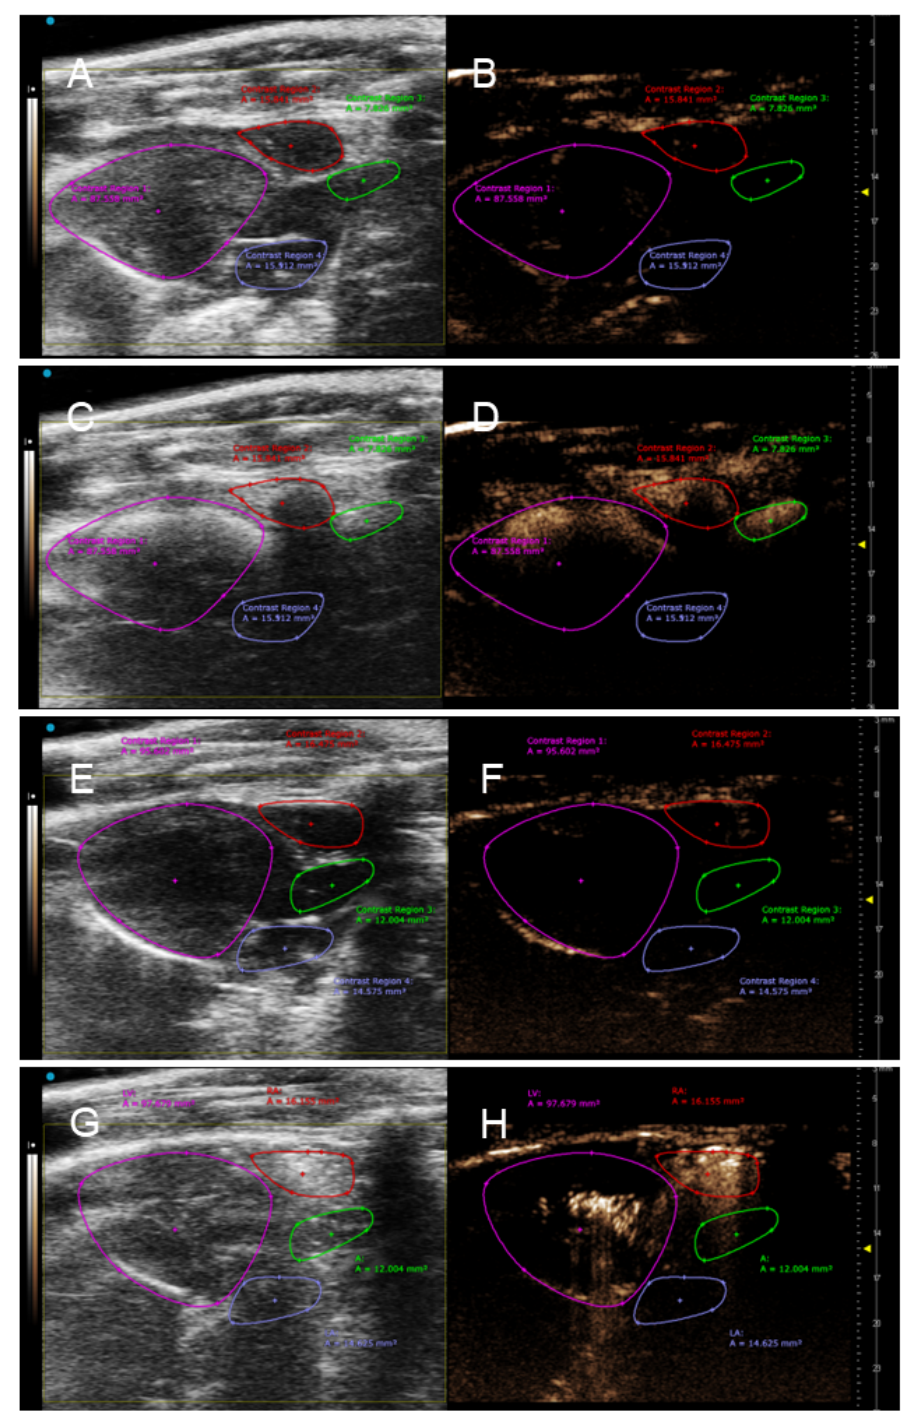
Figure 2. In vivo imaging of rat heart after administration of two different contrast agents. Repre- sentative images of rat heart in PSLAX before intravenous tail vein administration of 220 µ L Vevo MicroMarker ( B ) and 2 mL of CO 2 foam ( F ) and 5 s later ( D , H ). Corresponding images in B-Mode are in the left panel ( A , C , E , G ). The NLC signal was observed inside the right atrium (red), left atrium (blue), aorta (green) and left ventricle